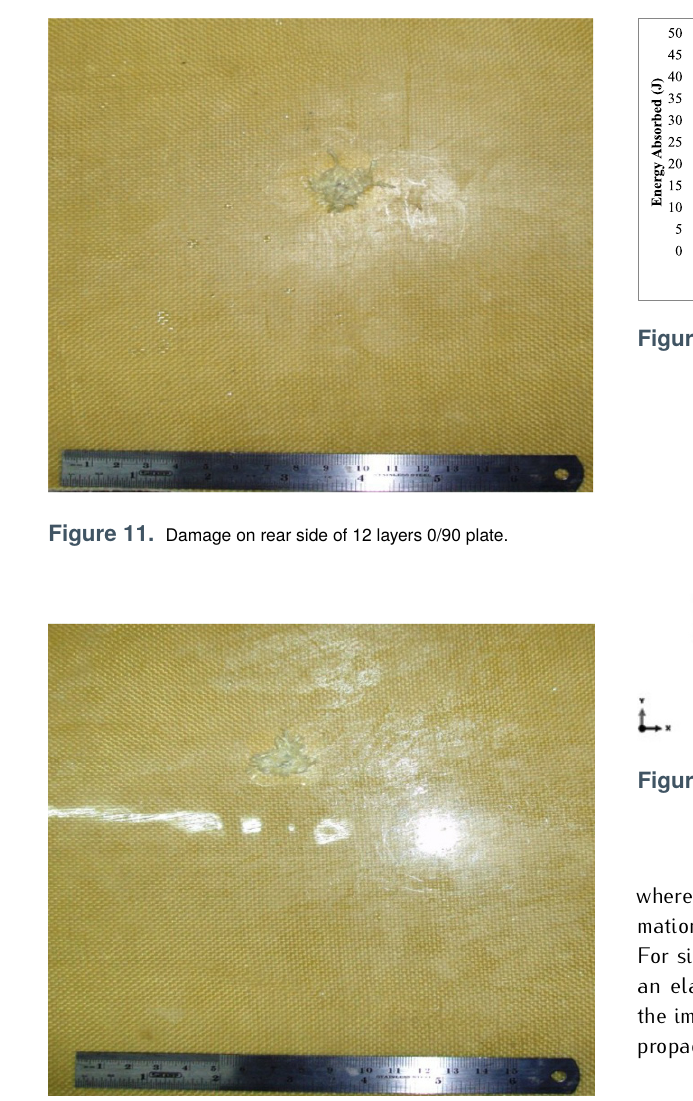
Figure 12. Damage on rear side of 8 layers 0/90 plate.